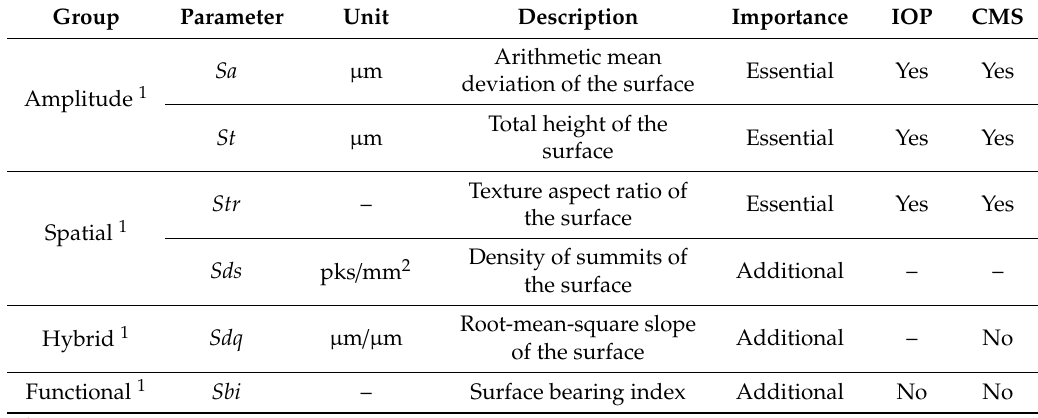
Table 3. Surface texture parameters used for characterization of the surface of industrial planer knives. Group Parameter